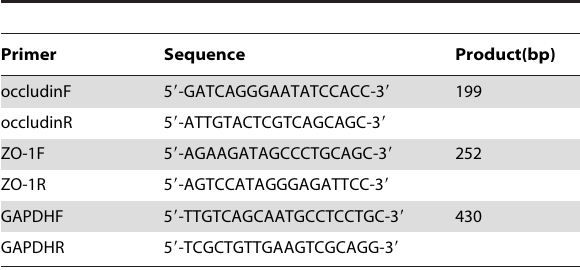
Table 1. Sequence of primers for occluding, ZO-1, and